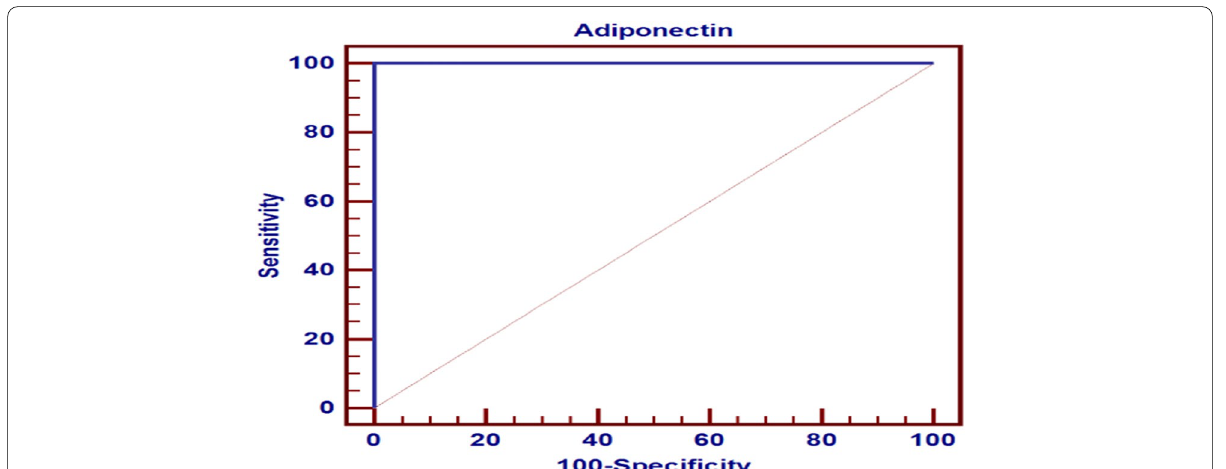
Fig. 1 ROC for adiponectin level as a predictor for liver